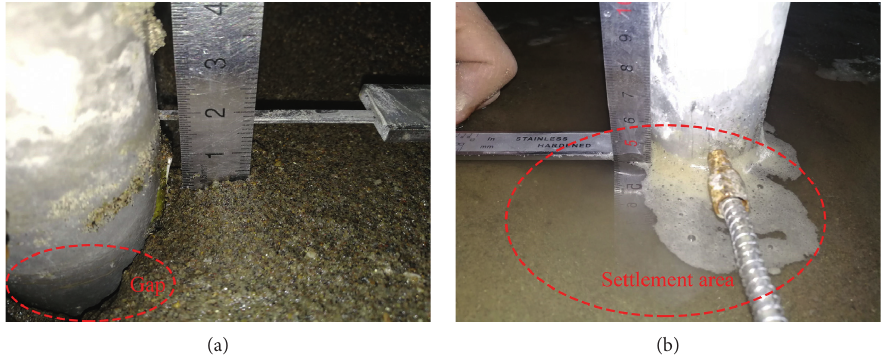
Figure 16: The gap and the settlement around pile: (a) case 2; (b) case 6.